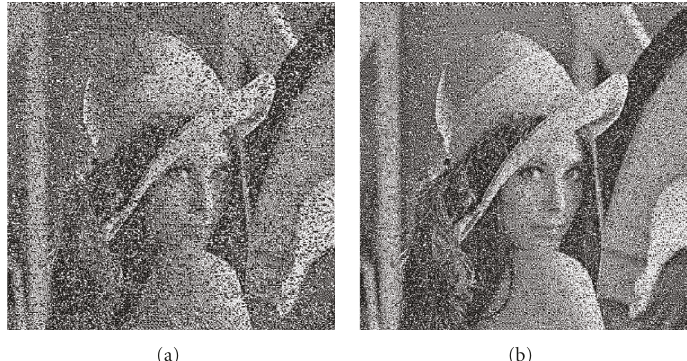
Figure 16: The generated stego images with and without applying the weight adjusting operation: (a) without the weight adjusting and (b) with the weight adjusting.